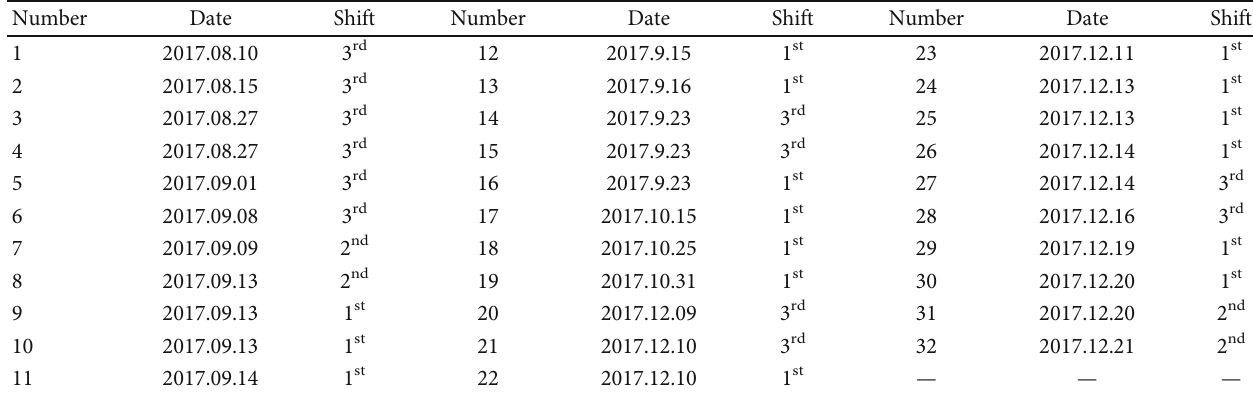
Table 4: Jet holes events in 11224 transportation